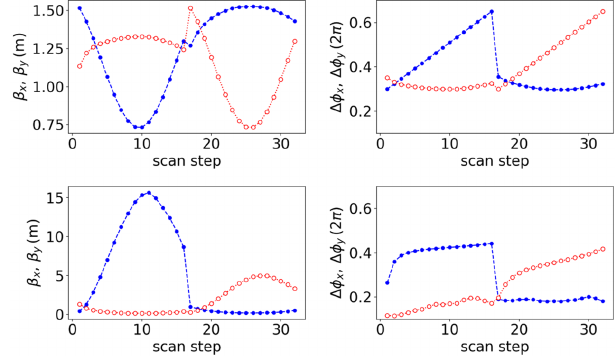
FIG. 2. Optics functions in the CLARA tomography measure- ments, in the design model (top) and the calibrated model (bottom). Left-hand plots show the beta functions at the obser- vation point at each step in the quadrupole scan; right-hand plots show the phase advances from the reconstruction point to the observation point at each step in the quadrupole scan. Blue solid points (with dashed lines) show the values in the horizontal plane; red open points (with dotted lines) show the values in the vertical